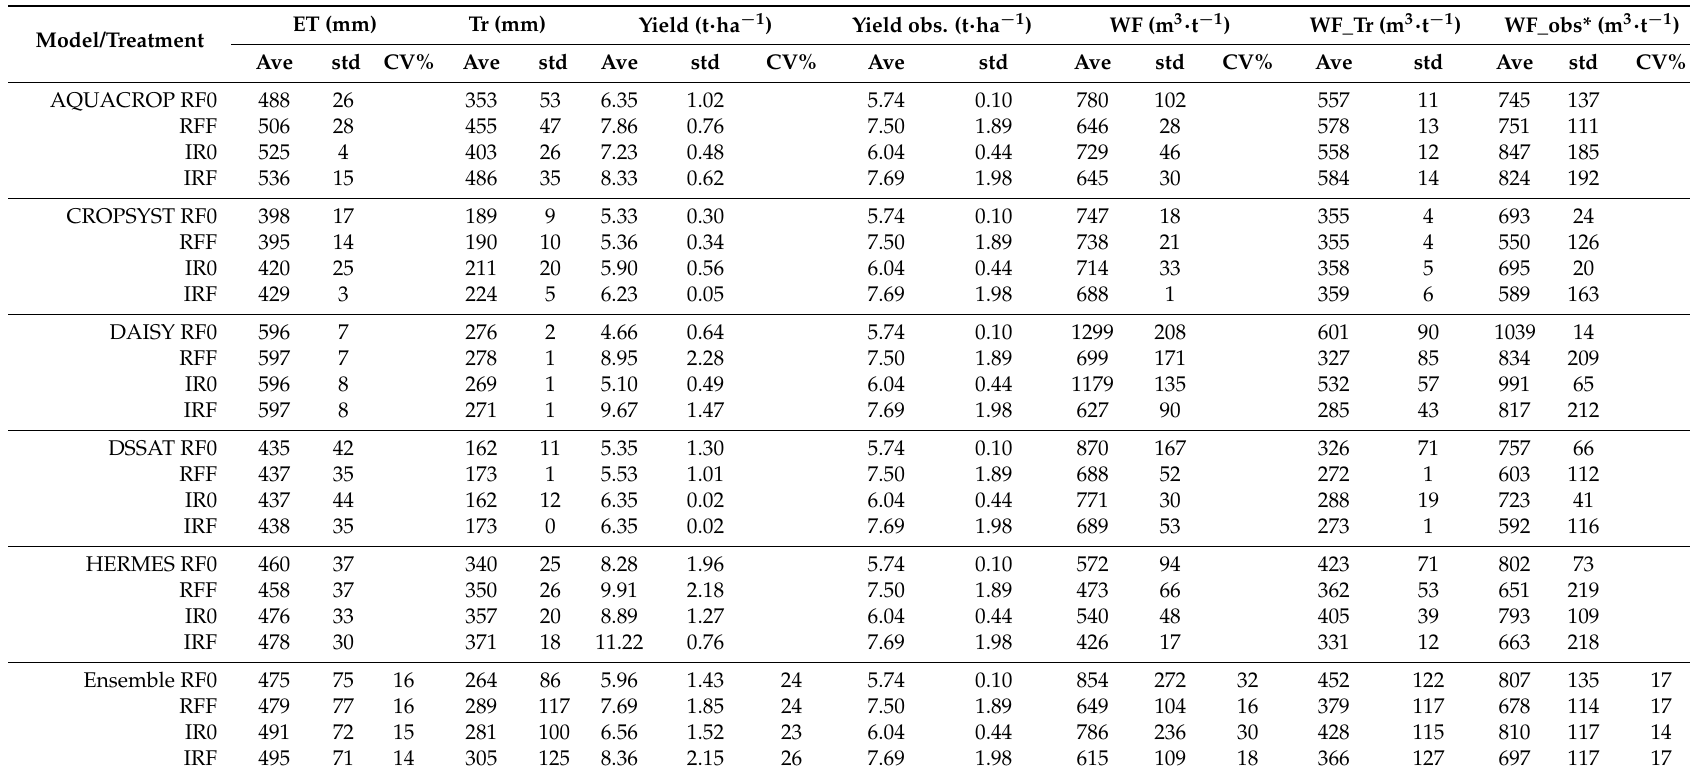
Table 5. Simulated actual evapotranspiration (ET), transpiration (Tr), grain yield (86% d.m.) and resulting water footprints based on ET (WF) and transpiration (WF_Tr) for winter wheat for rainfed and irrigated combined with fertilized and unfertilized treatments at Bratislava/Slovakia from different models. WF_obs* indicate water footprints based on simulated ET and measured yields. Ave is the average value, std indicates the standard deviation and CV% the coefficient of variation in percent (only for the ensemble